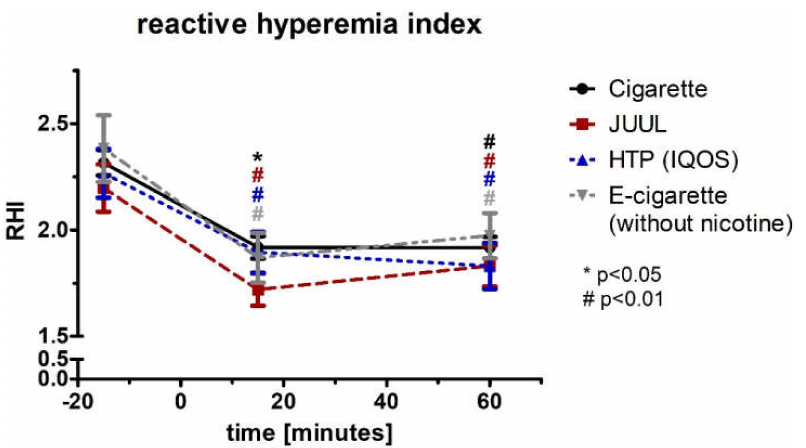
Figure 7. Reactive hyperemia index before and 15 as well as 60 min after consuming the cigarette, JUUL TM , heated tobacco product, and e-cigarette without